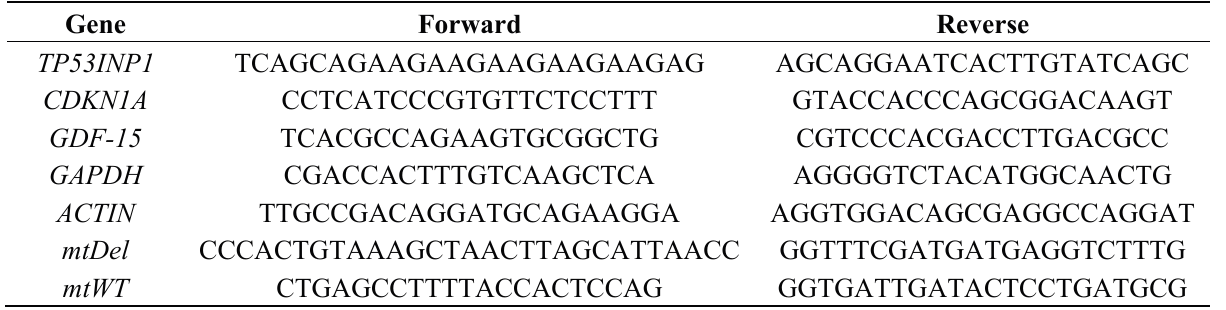
Table 1. Oligonucleotide primers used in quantitative real